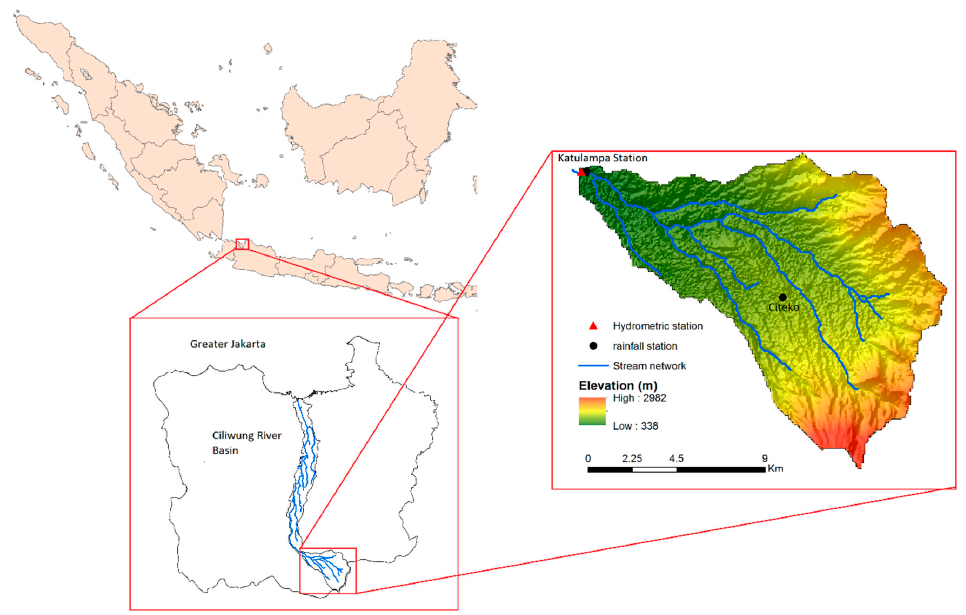
Figure 1. The locations of the study area: the Ciliwung Basin and Bogor Basin. Hydrometric and climatological stations and hypsometric classes are also shown.